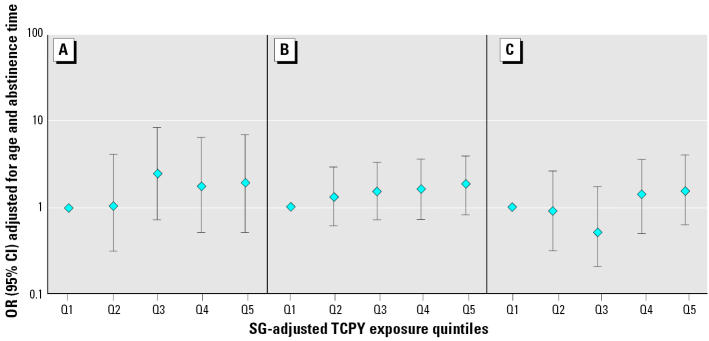
Adjusted ORs and 95% CIs for below-reference semen parameters by increasing quintiles of TCPY for (A) sperm concentration (p-value for trend = 0.21), (B) motility (p-value for trend = 0.15), and (C) morphology (p-value for trend = 0.26). The quintiles of SG-adjusted TCPY (μg/L) are as follows: Q1 (low), < LOD to 1.45; Q2, 1.45–2.72; Q3, 2.72–3.85; Q4, 3.85–5.59; Q5 (high), 5.59–40.69.